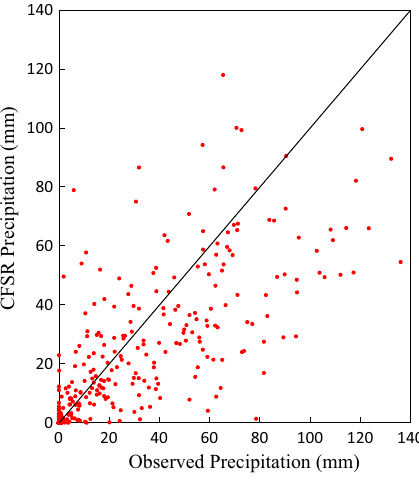
Fig. 10 Comparison of monthly observed and CFSR